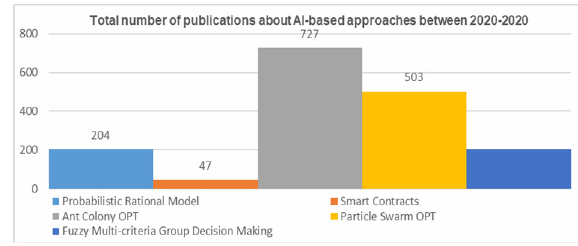
Figure 3. Publications about AI-based approaches.